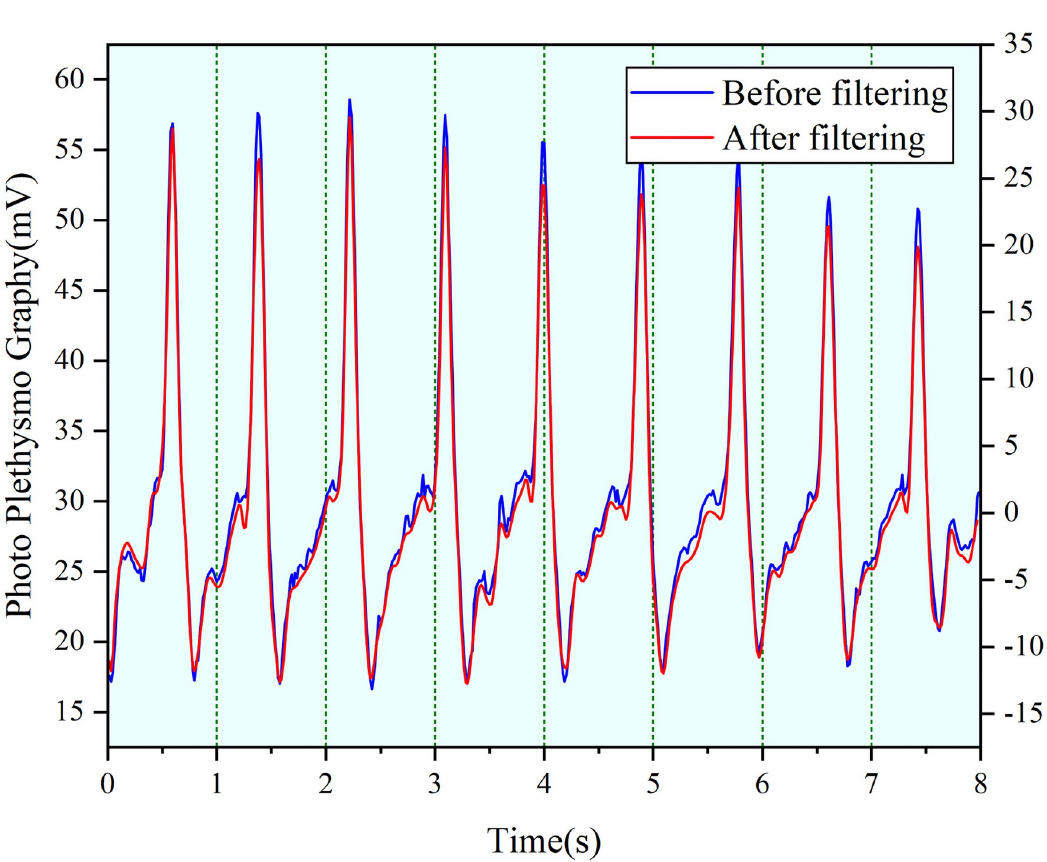
Fig 16. Regression analysis of PPG signal parameter correlation.